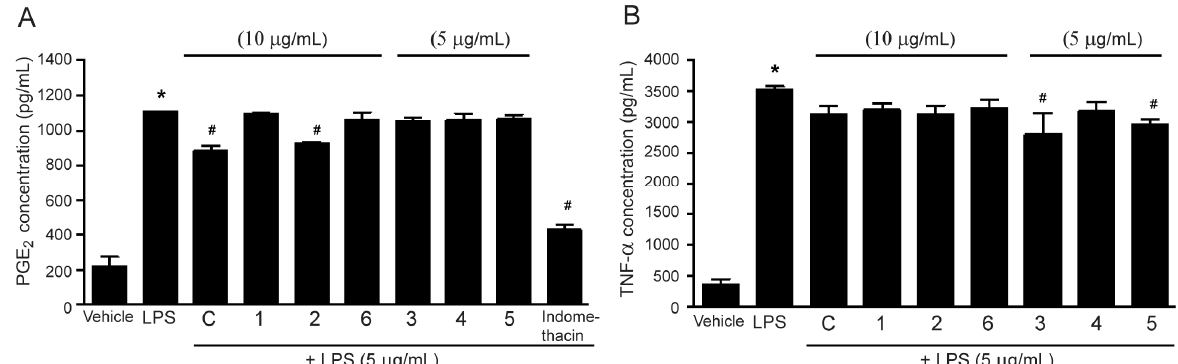
Figure 4. Effects of the methanol extract and isolated lignans 1 − 6 from M. sirikitiae leaves on LPS- induced PGE 2 and TNF- α secretion in RAW 264.7 cells; Serum-starved cells were pretreated with crude methanol extract (C) (10 µ g/mL), lignans (5 or 10 µ g/mL), or indomethacin (10 µ M) for 3 h, and then stimulated with LPS (5 µ g/mL) for 24 h at 37 ◦ C. The levels of PGE 2 and TNF- α secreted into the medium were assessed by ELISA assay. The relative PGE 2 ( A ) and TNF- α ( B ) levels were quantified using a standard curve and expressed as the mean ± SEM ( n = 3). *, p < 0.05 vs. vehicle; #, p < 0.05 vs. LPS.